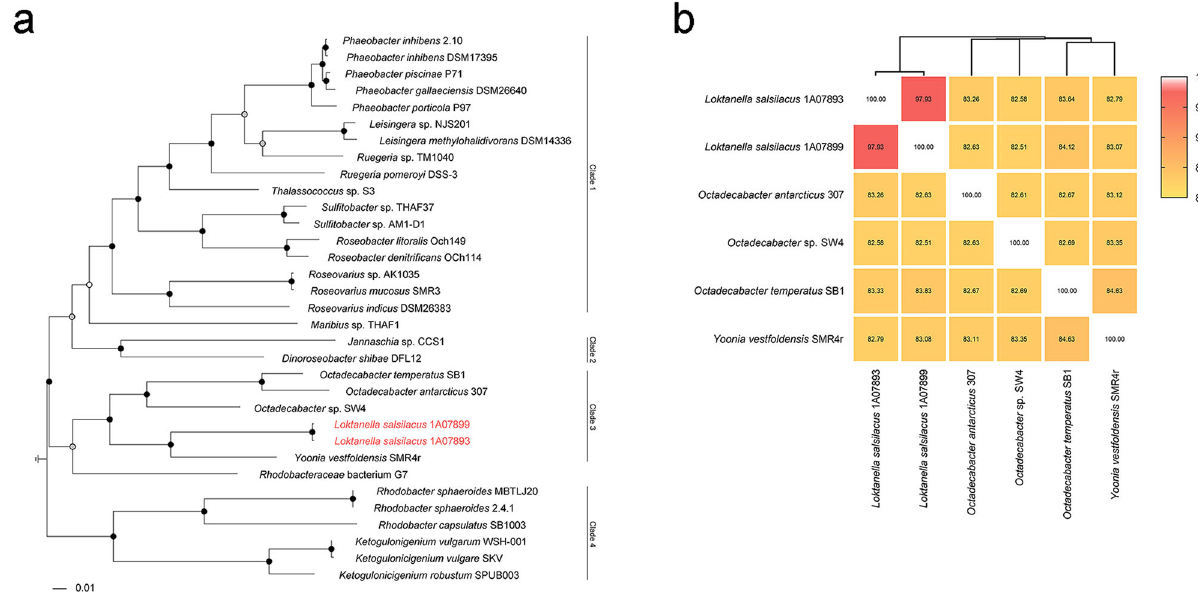
Fig. 3 Evolutionary relationship between L. salsilacus and other representative RGB. a Phylogenetic tree based on the concatenation of 12 housekeeping genes ( dnaG , frr , infC , nusA , pgk , pyrG , rplC , rpmA , rpoB , rpsC , smpB , and tsf ). Bootstrap values generated by 1000 bootstraps were labeled at nodes (white, ≥ 35%; gray, ≥ 50%; black, ≥ 75%). b Pairwise comparisons between L. salsilacus and closely related strains to reveal average nucleotide identity (ANI) values. ANI values were labeled in corresponding cells of the heatmap, and phylogenetic distances were calculated by a complete clustering algorithm based on Euclidean